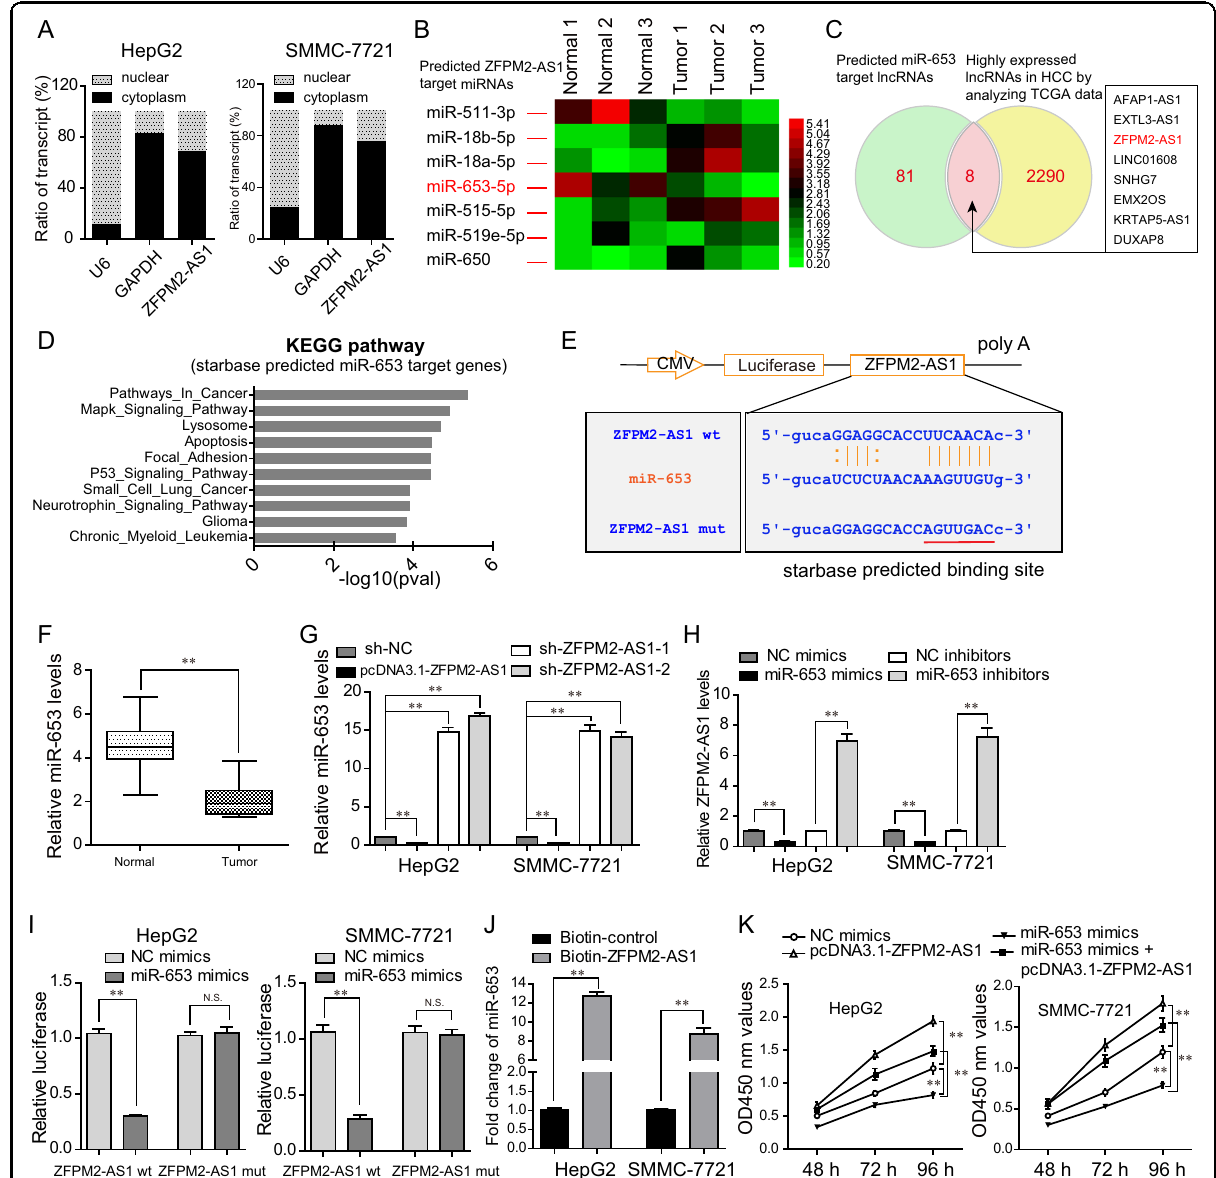
Fig. 6 ZFPM2-AS1 acted as a sponge of miR-653 in HCC cells. A Subcellular location detection for ZFPM2-AS1 in HepG2 and SMMC-7721 cells. B Starbase algorithm predicted the target miRNAs of ZFPM2-AS1, and qPCR analyses were performed to evaluate the levels of these predicted miRNAs. The results were presented using heatmap form. C Venn diagram showed the intersection of predicted miR-653 target lncRNAs and highly expressed lncRNAs in HCC tumor samples. D Starbase algorithm analyzed the KEGG pathway of predicted miR-653 target genes. E The binding sites of miR-653 on ZFPM2-AS1. F Real-time PCR detected the relative miR-653 levels in 127 HCC samples. G MiR-653 levels in HCC cells were assessed by qPCR analyses when their ZFPM2-AS1 was overexpressed or knocked down. H ZFPM2-AS1 levels in HCC cells were assessed by qPCR analyses when their miR-653 was overexpressed or knocked down. I Luciferase reporter assays. J RNA-pulldown assays. K CCK-8 assays detected the cellular growth of HCC cells after various treatment. Data are presented as the mean ± SD from three independent experiments. * P < 0.05, ** P <